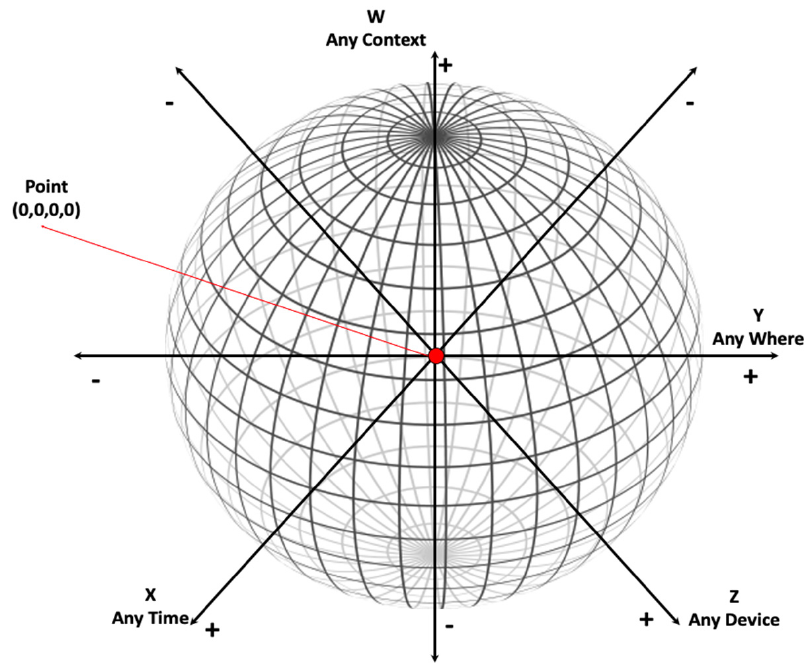
Figure 5. Hypersphere in four dimensions [2].